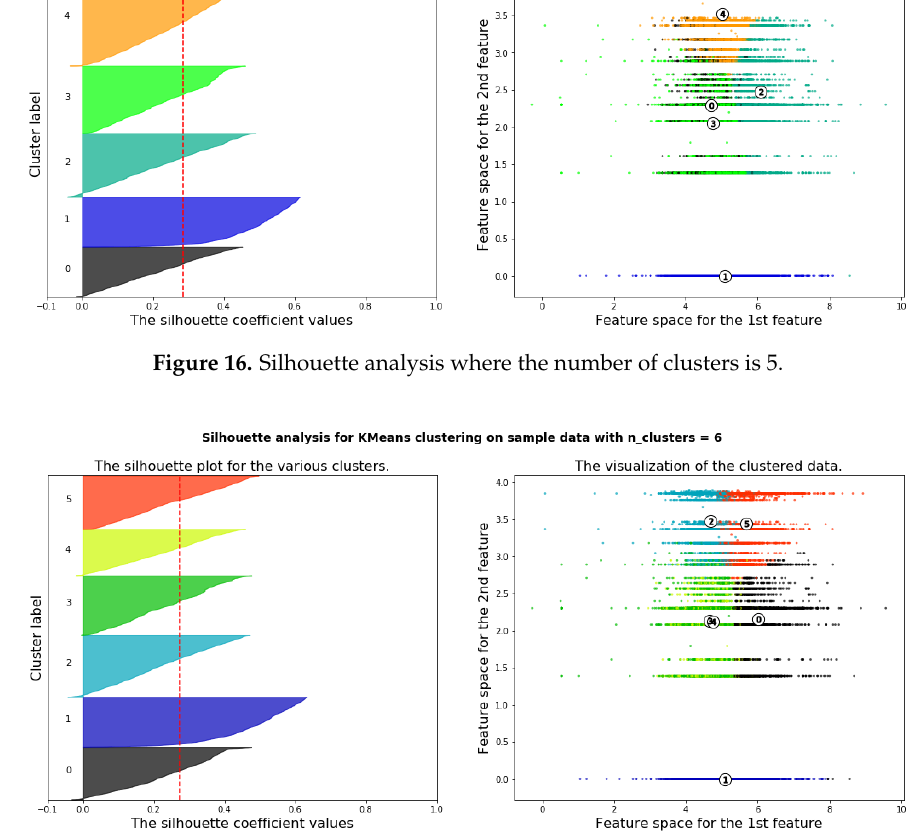
Figure 17. Silhouette analysis where the number of clusters is